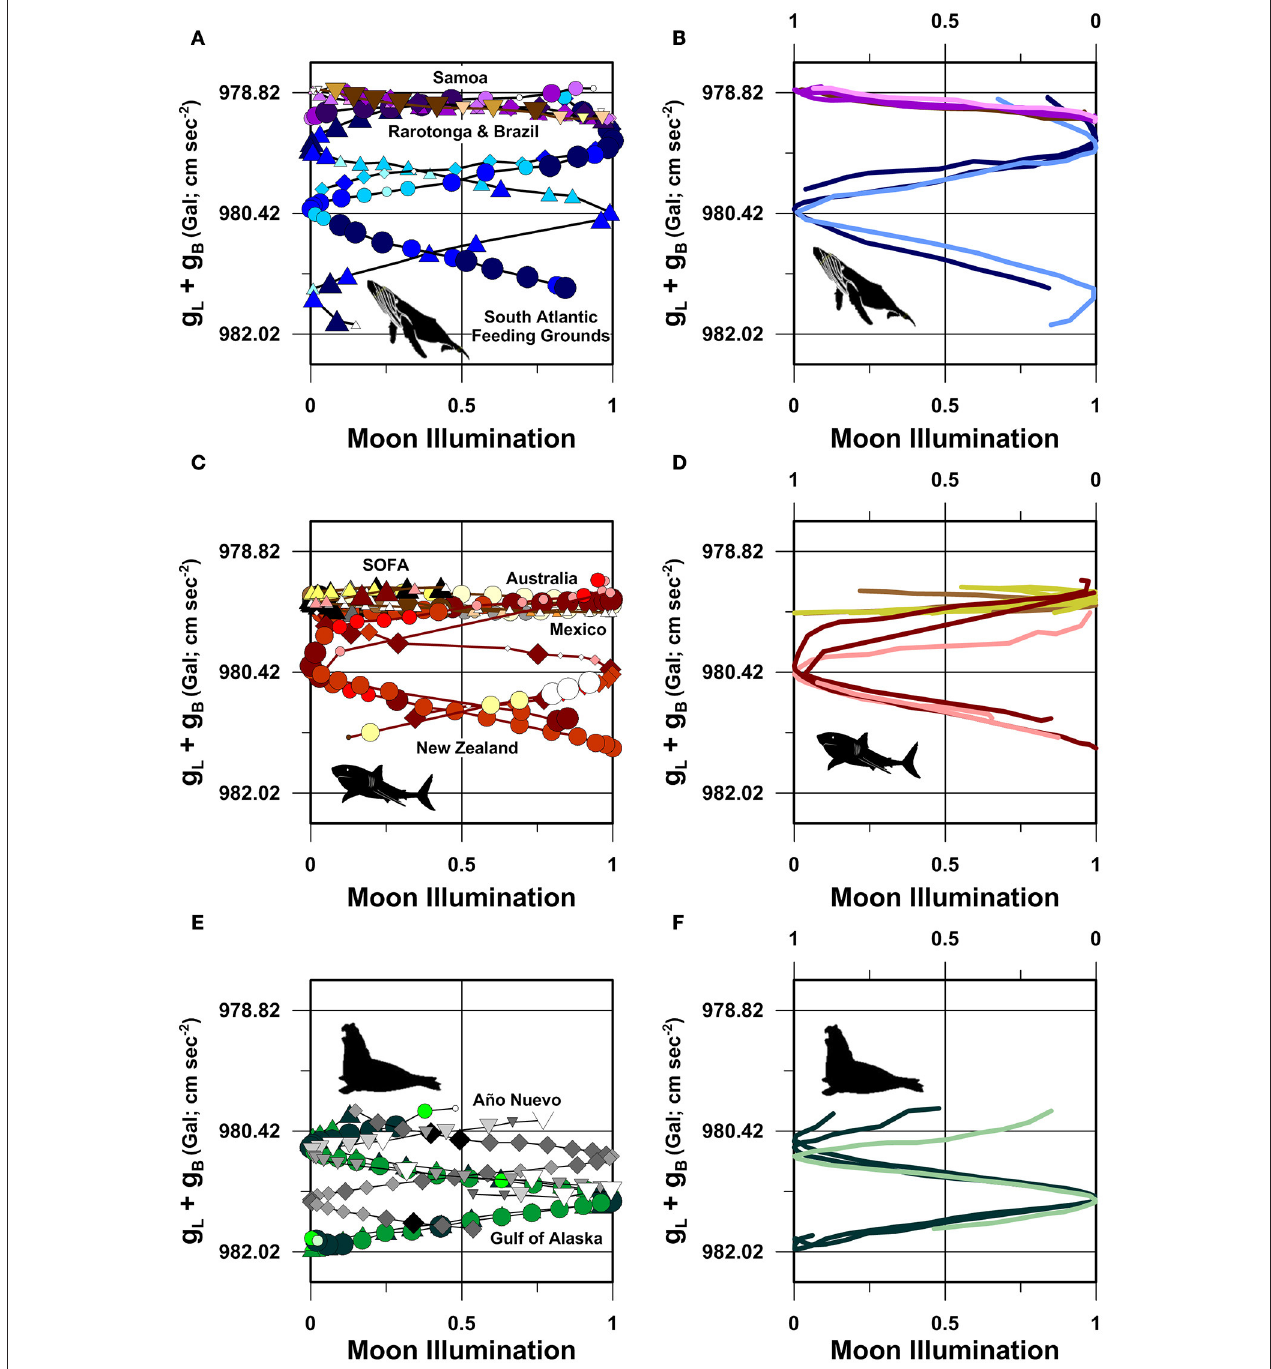
FIGURE 6 | Latitude and bedrock dependent gravity vs. moon illumination “g-space” plots. (A,B) Humpback whales in the South Atlantic and South Pacific Oceans, (C,D) great white sharks in the South Pacific and North Pacific Oceans, (E,F) northern elephant seals in the North Pacific Ocean. Symbols as in Figures 1 - 3 . In (B,D,F) , average daily location symbols have been removed, and in (B,F) the same tracks are plotted against the upper reverse moon illumination axis as in Figures 5B,F . In (D) , PTT numbers 19787.09, 19787.12, 20720.09, 20720.10, and 20720.11 are plotted against the upper reverse moon illumination axis and PTT numbers 19787.10 and 19787.11 are plotted against the lower moon illumination axis. All mirror-image tracks plotted against the upper moon illumination axis are displayed as lighter color lines. g L + g B corresponds with the sum of the latitude (g L ) and bedrock (g B ) dependent vertical gravitational accelerations at each individual location (see